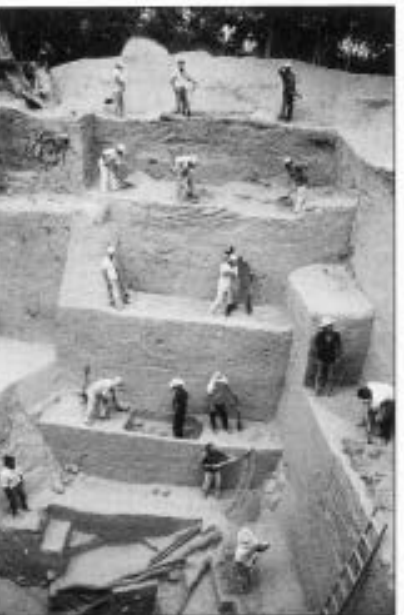
Figure 2 Excavation by Izumi Shimada of an elite tomb at Huaca las Ventanas, Sicdn, northern Peru; many bundles of naipes were found in the tomb and else­ where at the